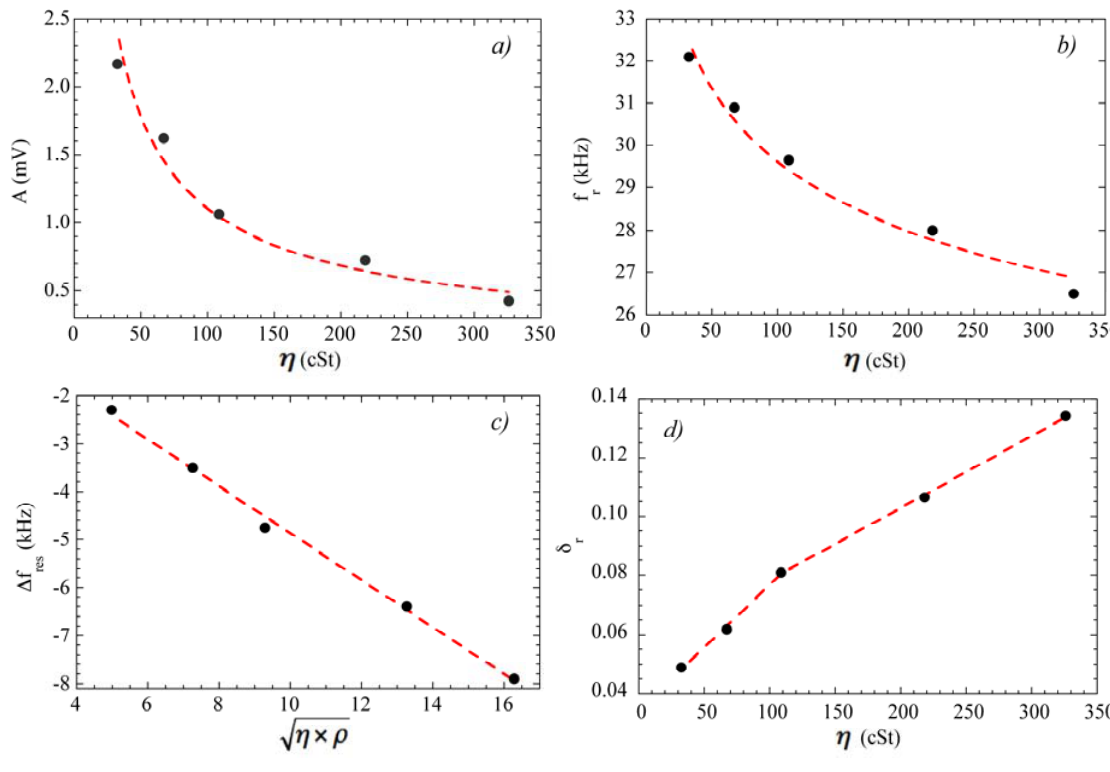
Figure 11. Dependence of best-fit parameters on oil viscosity η . ( a ) Amplitude of the resonance; ( b ) Resonance frequency; ( c ) The resonance frequency shift (from the resonance frequency in air) scales with the square root of the product of the viscosity times the density of the oil; ( d ) Damping